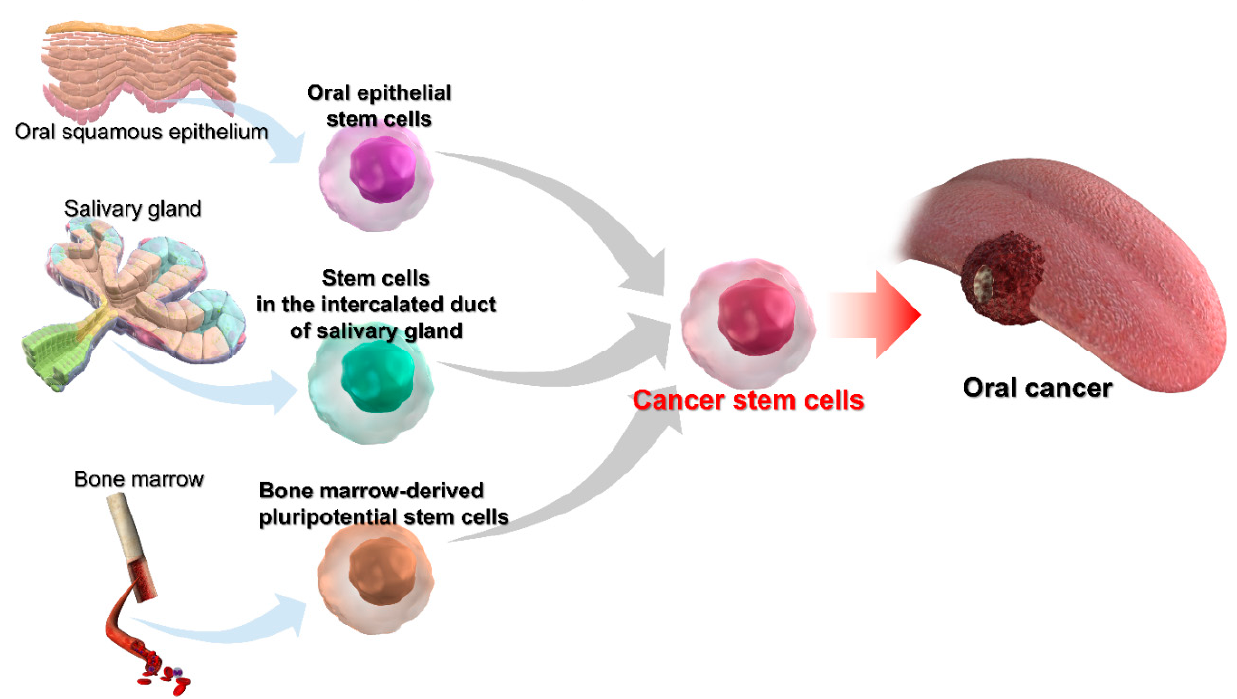
Figure 3. The illustration of the development of OSCC by several CSCs. Cancer that develops from more undifferentiated stem cell-derived CSCs is considered to shows “stemness” and high malignancy (invasion, metastatic potential). BM-derived stem cell-derived CSCs are more undifferentiated than oral epithelial stem cell-derived CSCs or stem cells in salivary gland-derived CSCs. Conventionally, most cases of OSCC have been viewed as developing through “gain of function” as an accumulation of genetic abnormalities in oral epithelial stem cells or salivary gland stem cells, gaining the potential for proliferation, invasion, and metastasis [77]. This idea may be proposed based on the con- cept of “fundamentally good”, in which normal cells do not behave similarly to malignant cells (that is, infinite proliferative capacity, tissue infiltration by epithelial–mesenchymal transition, evasion from drugs by hiding in a niche, efflux of drugs from inside of cells, anti-apoptosis, anti-terminal differentiation, angiogenic potential, survival in blood vessels, and survival and proliferation in an ectopic environment). In contrast, we would like to propose that the development of highly malignant cancer from more undifferentiated stem cell-derived CSCs is based on the concept of “fundamentally evil.” The above char- acteristics of malignant cells are consistent with the stemness of pluripotent stem cells, such as BM-derived stem cells. Pluripotent stem cells with these characteristics behave as differentiated normal cells in their environment, masking their stemness, probably by the methylation of the genes. When genetic abnormalities accumulate in pluripotent stem cells and they become CSCs, their original masked characteristics, i.e., stemness, are exhibited, and the tumor cells show extremely malignant behavior. This can be explained by the hypothesis that there is another multistep carcinogenesis model that allows the malignant transformation to proceed by gain of oncogenic function and the loss of masked stemness, i.e., “loss of function” (Figure